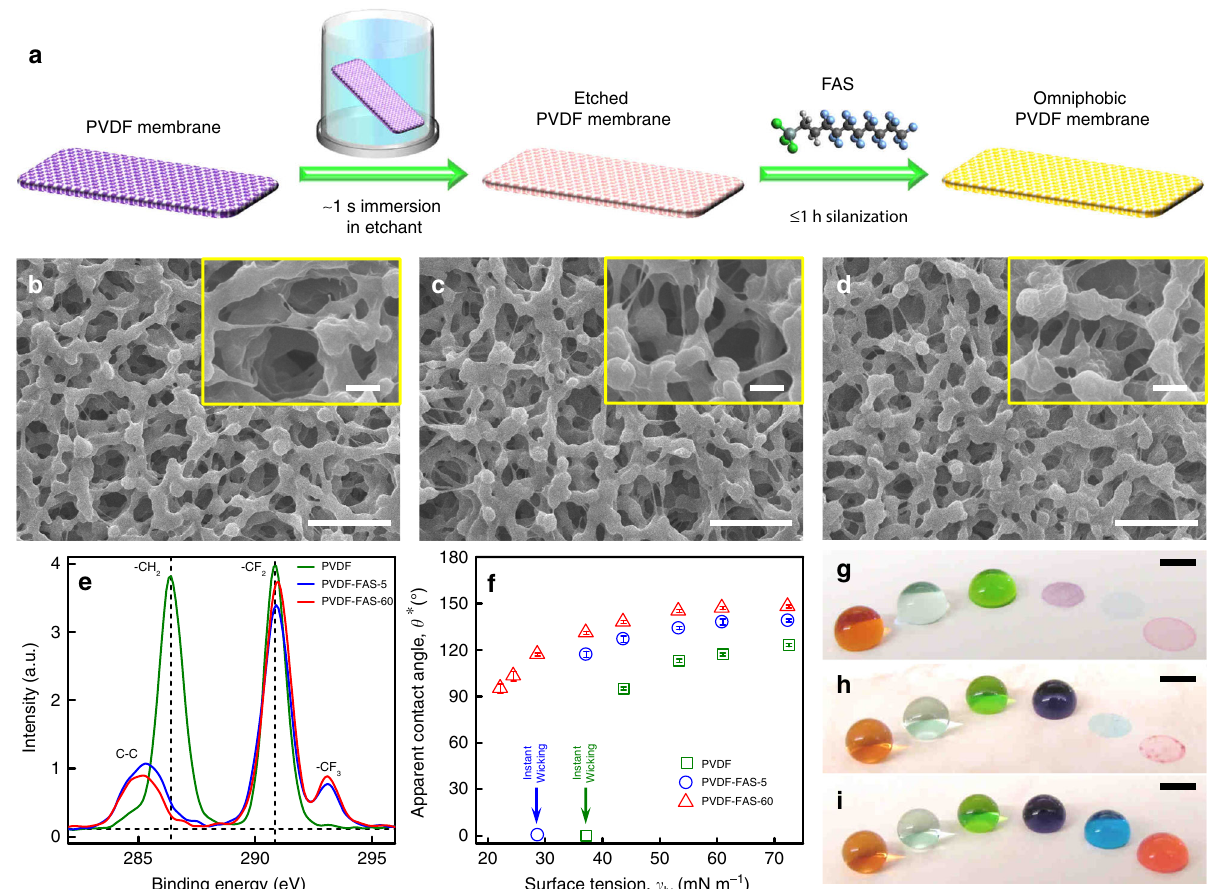
Fig. 1 Fabrication and characterization of monolithic omniphobic membranes. a Schematic depicting the fabrication of omniphobic membranes. Scanning electron microscope (SEM) images of b pristine polyvinylidene di fl uoride (PVDF) membrane, c PVDF-FAS-5 membrane, and d PVDF-FAS-60 membrane. FAS refers to heptadeca fl uoro-1,1,2,2-tetrahydrodecyl trichlorosilane. The scale bars represent 5 and 1 μ m (inset), respectively. e High resolution C1 s XPS spectra of the membranes. f Apparent contact angles of liquids with different surface tensions on the membranes. Error bars represent standard deviation from three independent measurements. The green and blue arrows point to the surface tension at which liquid instantly wicked into pristine PVDF and PVDF-FAS-5 membranes, respectively. g – i Images showing different liquids beading up on or wetting g pristine PVDF membrane, h PVDF-FAS-5 membrane, and i PVDF-FAS-60 membrane. The droplets from left to right: water ( γ lv = 72.5 mN m − 1 ), 1.5 mM sodium dodecyl sulfate (SDS) in water ( γ lv = 61 mN m − 1 ), 20% ethanol in water ( γ lv = 43.7 mN m − 1 ), 30% ethanol in water ( γ lv = 37.2 mN m − 1 ), 60% ethanol in water ( γ lv = 28.7 mN m − 1 ), 100% ethanol ( γ lv = 22.2 mN m − 1 ). The scale bars represent 2